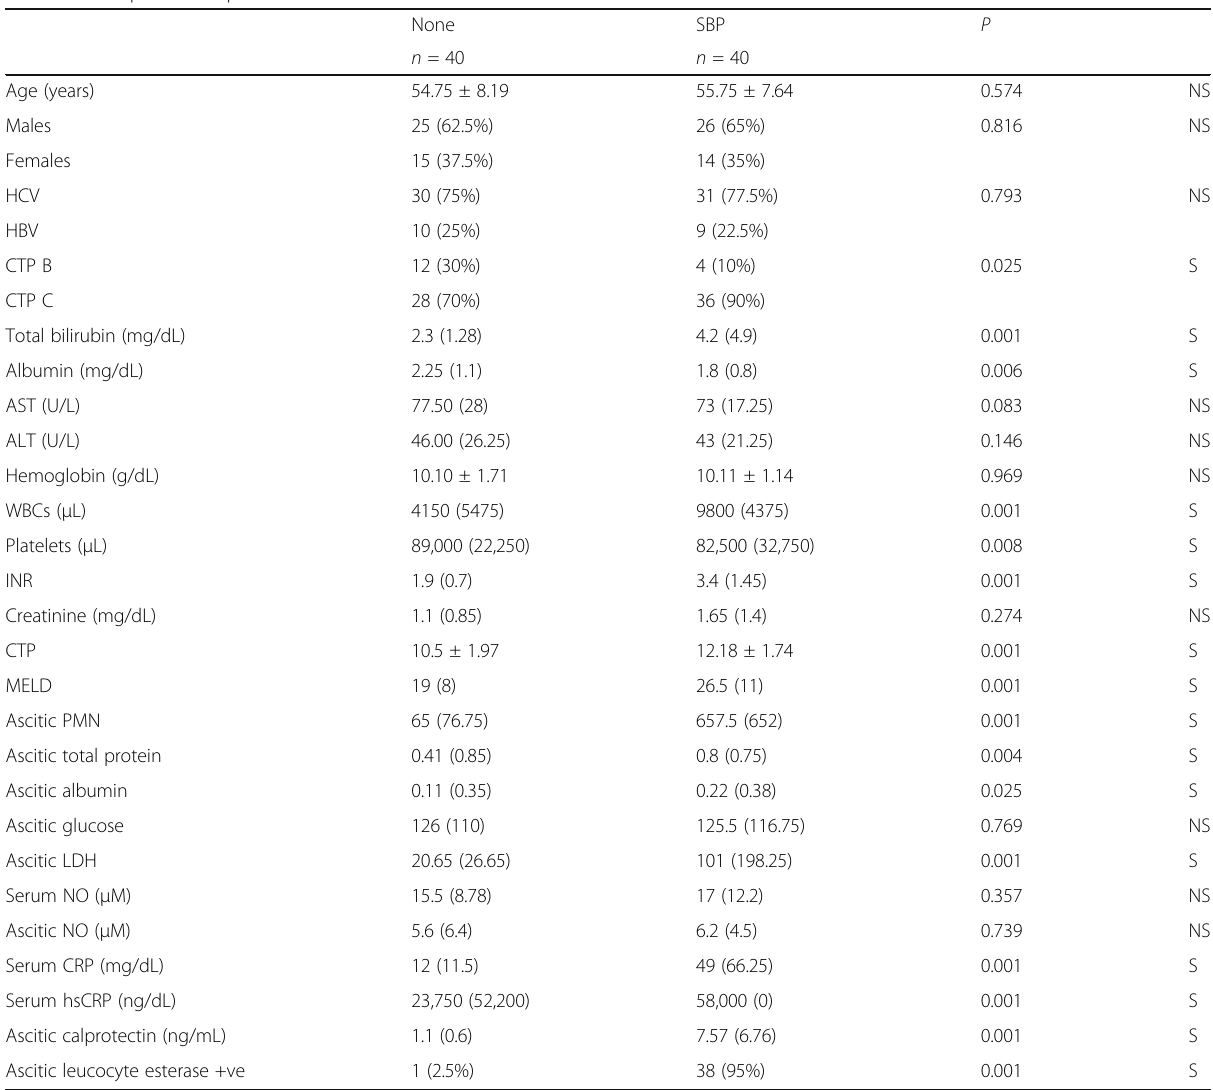
Table 1 Comparison of patients with and without SBP